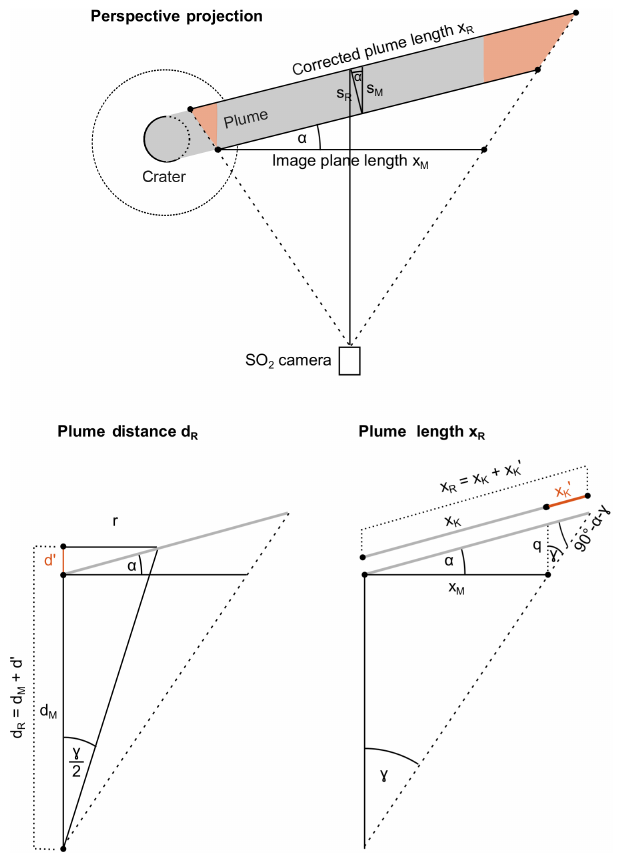
Figure 2. Schematic sketch of the influence of a large FOV angle on the deviation of the plume length x R from the assumed plume length x M and on the plume distance d R from the assumed plume distance d M . The additional distance the plume travels in comparison to the case of a plume moving away from the camera ( α = 0) is marked in red. Here, only the case of a plume moving away from the camera ( α > 0) is